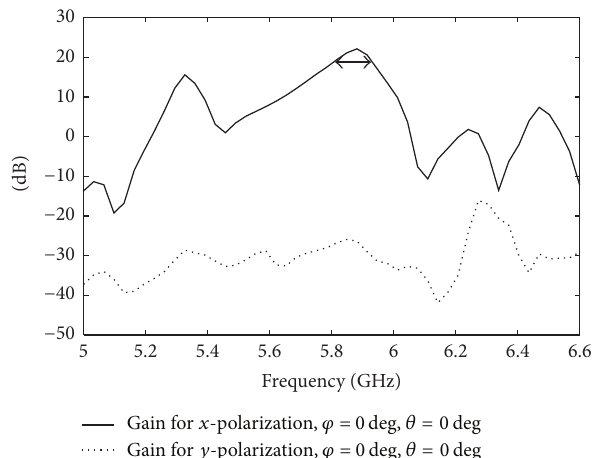
Figure 4: Simulated 𝑥 -component (copolarization) and 𝑦 -com- ponent (cross-polarization) of total gain versus frequency. 3 dB gain bandwidth is shown.